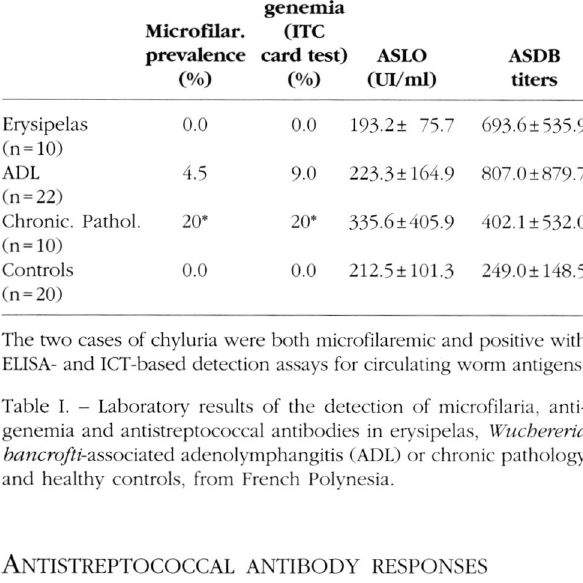
ANTISTREPTOCOCCAL ANTIBODY RESPONSES ASLO and/or ASDB antibodies were positive in 100 % of erysipela (p = 0.001, by comparison with controls), 75 % of of filarial ADL (p = 0.04), 50 % of chronic patho­ logy (p > 0.05, but not with the two chyluria), and 39 % of healthy controls (Table I). The ASLO titers were not significantly different between the four groups, but ASDB titers were higher in erysipela (p = 0.002) and ADL (p = 0.019), but not in patients with chronic patho­ logy (p > 0.05), than in